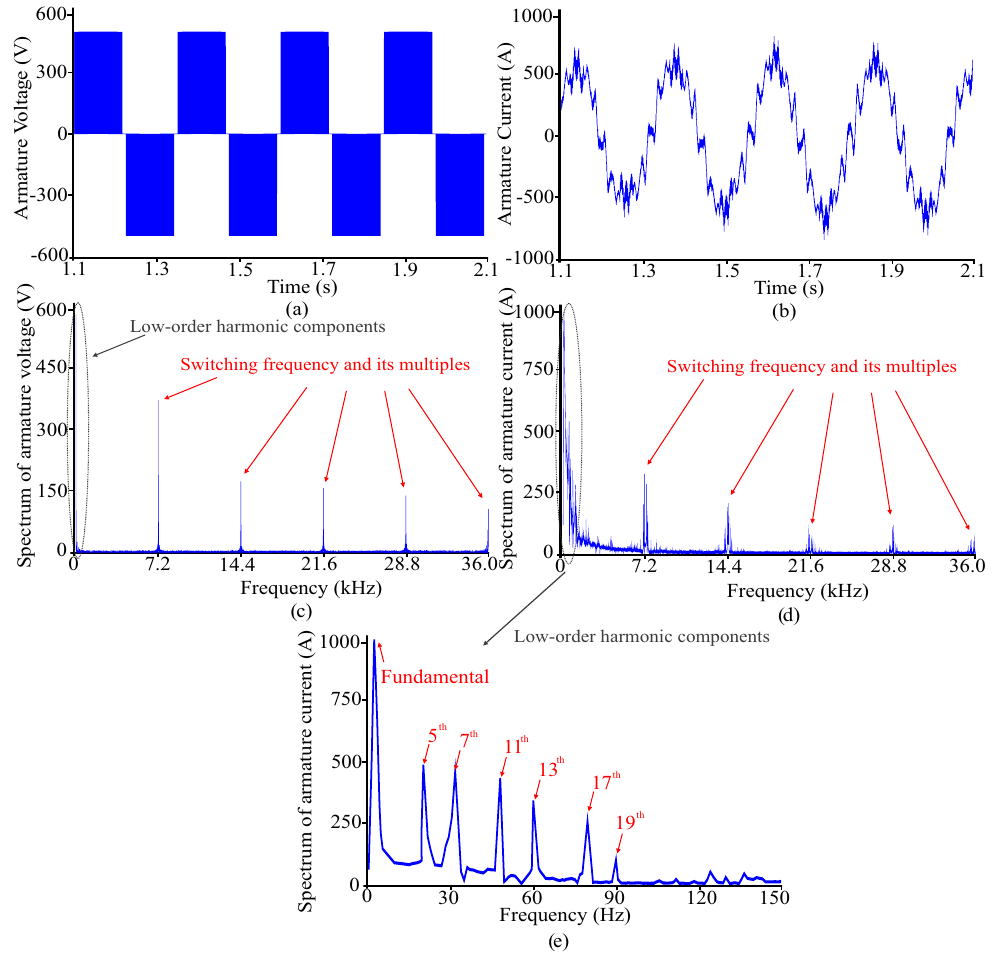
Figure 3. ( a ) Pole voltage applied to the EFR armature windings ( V efr s , a ). ( b ) Line current in phase a of the EFR armature ( I efr s , a ). ( c ) Frequency spectrum of V efr s , a . ( d ) Frequency spectrum of I efr s , a . ( e ) Zoom of the low-order harmonic components of I efr s , a .